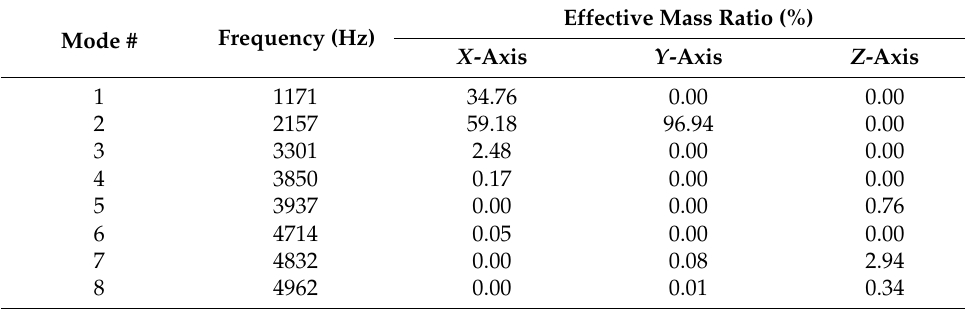
Table 2. Results from the modal analysis in ANSYS software [7].